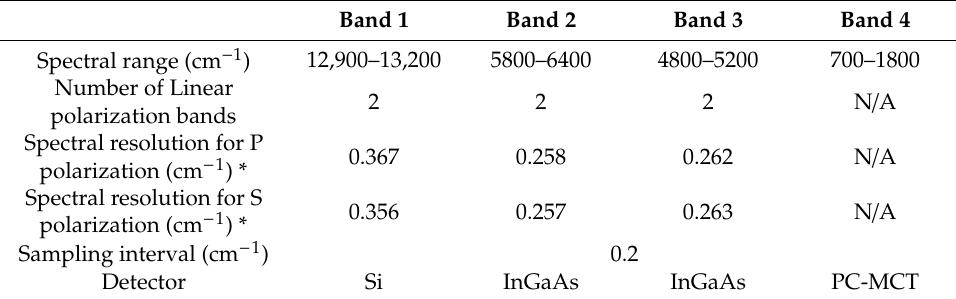
Table 3. Specifications of spectral